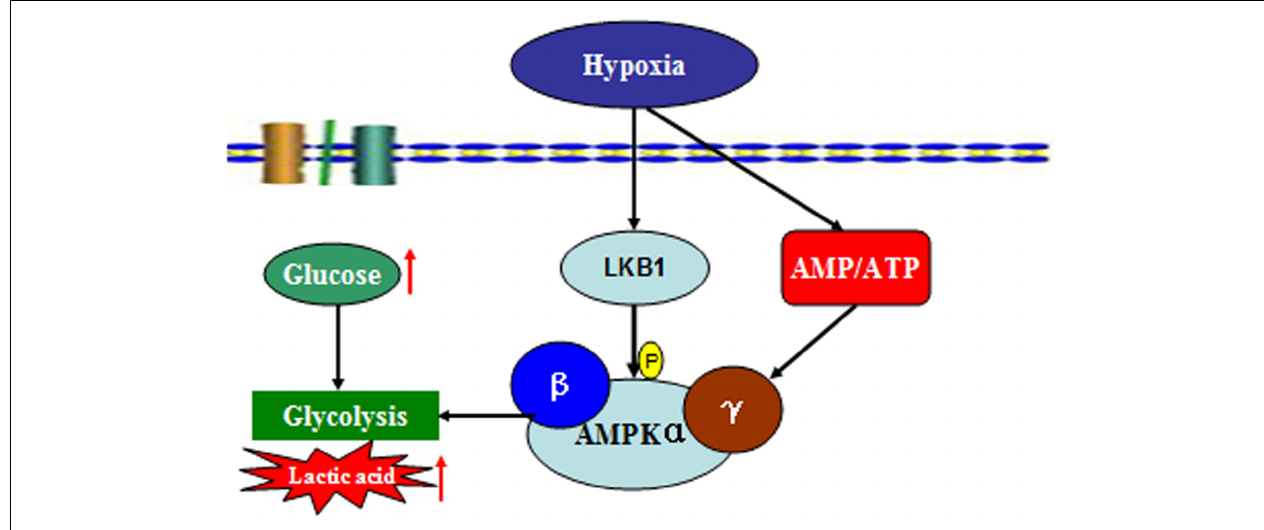
FIGURE 7 | Summary of the molecular signaling events and cellular responses related to energy metabolism and AMPK activation in the muscle tissue of M. nipponense under hypoxic